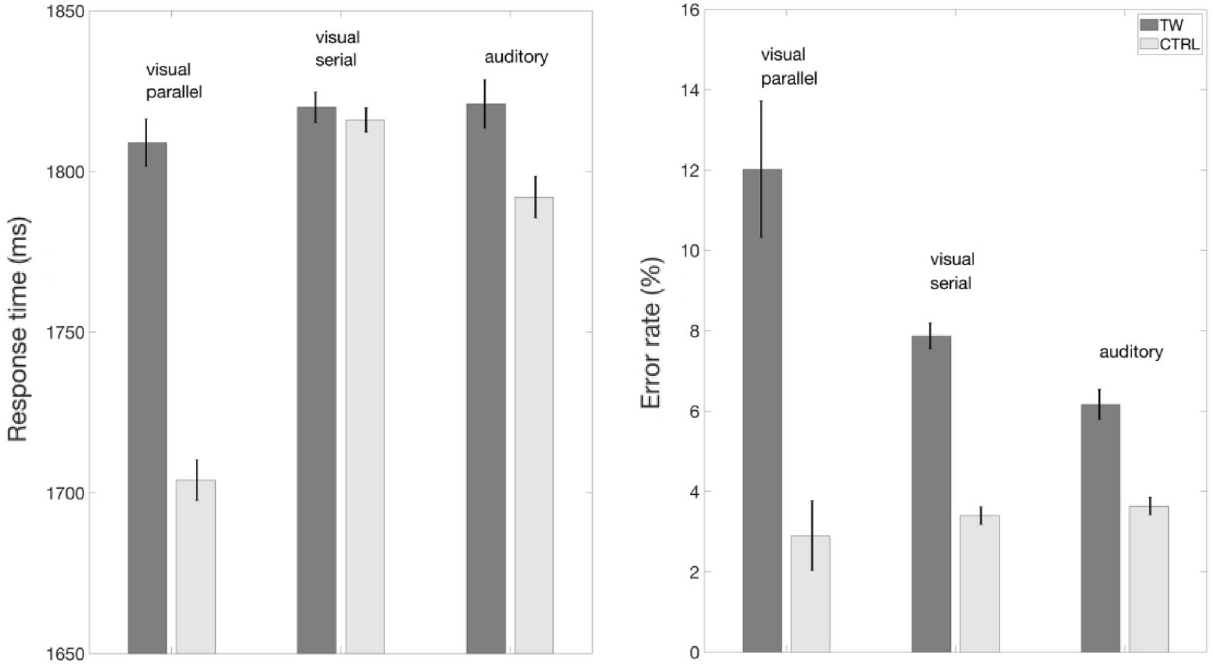
Figure 2. Comparison of transposed-word effects (transposed-word—TW vs. control—CTRL) obtained under parallel presentation of written words (visual parallel: Mirault et al., 2018), serial presentation of written words (visual serial: Mirault et al., 2022), and in the present study